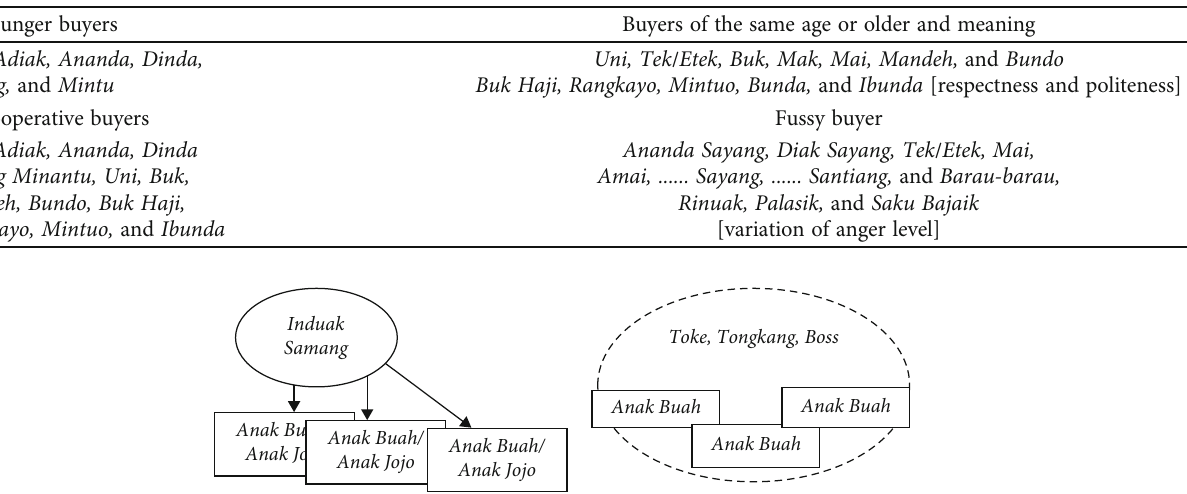
Figure 2: Variations of honori fi c deixis and television distinction pattern in the permanent. Relationship between buyers and traders in Pasa Bawah Bukittinggi. Note: Research data and analysis. Arrow is the direction of using deixis. Table 5: Temporary deixis from traders to women buyers in Pasar Bawah.